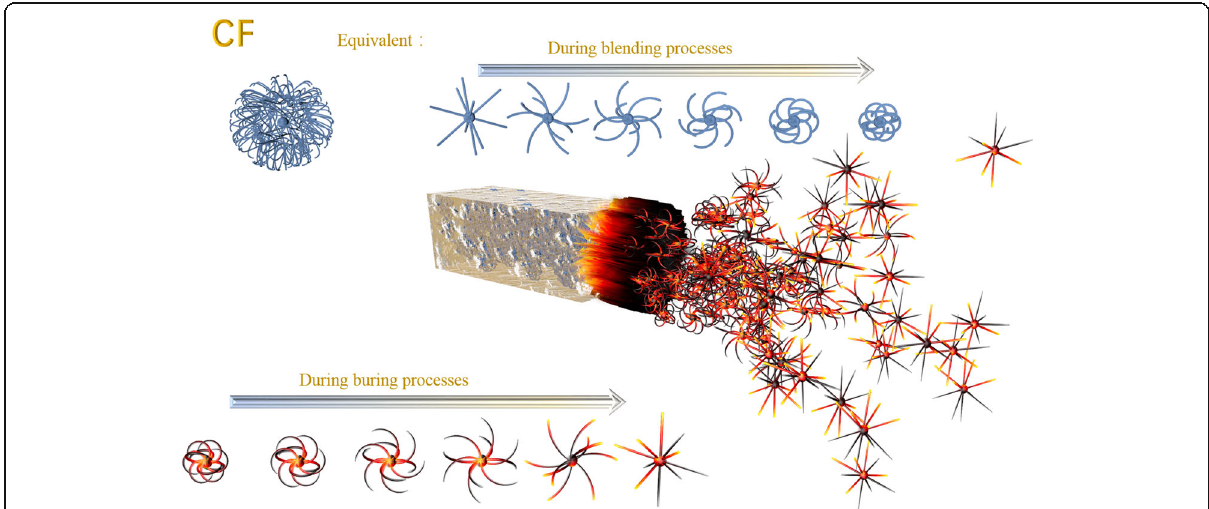
Fig. 3 The mechanism of generation of flying sparks during